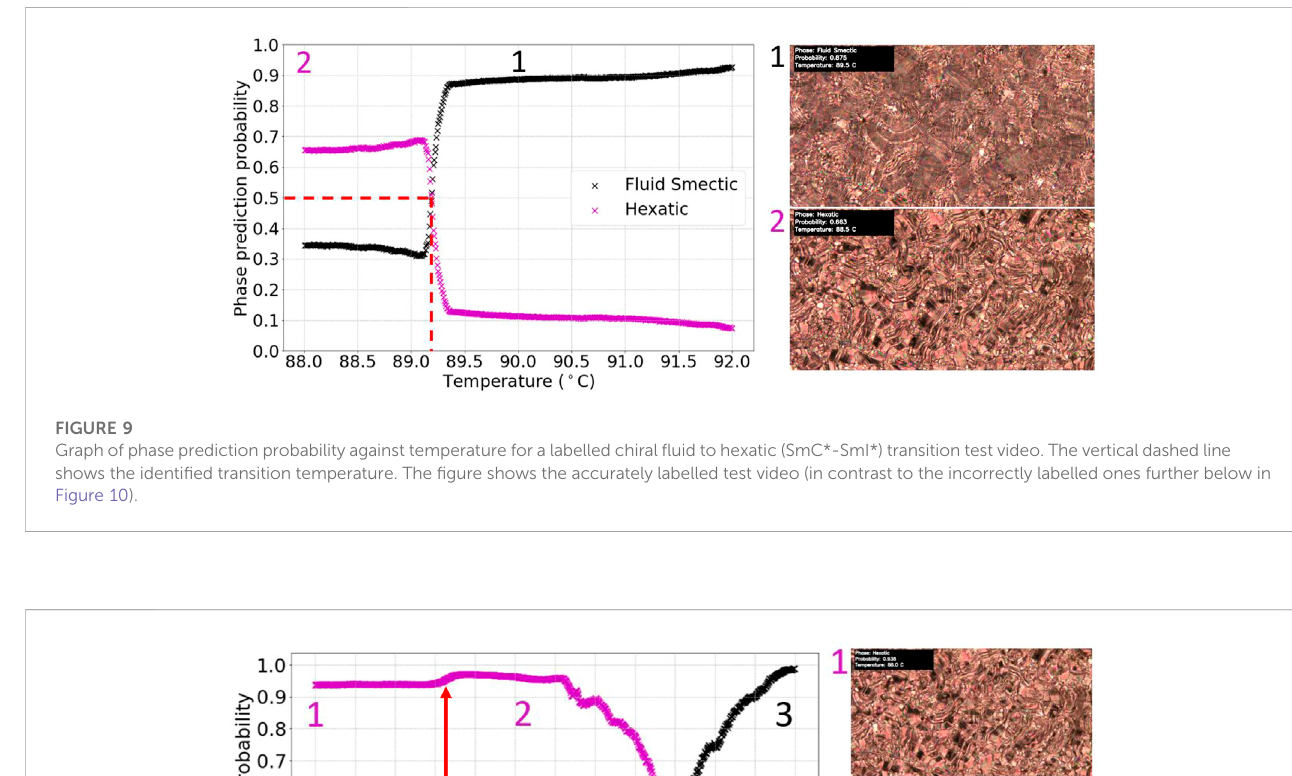
Frontiers in Soft